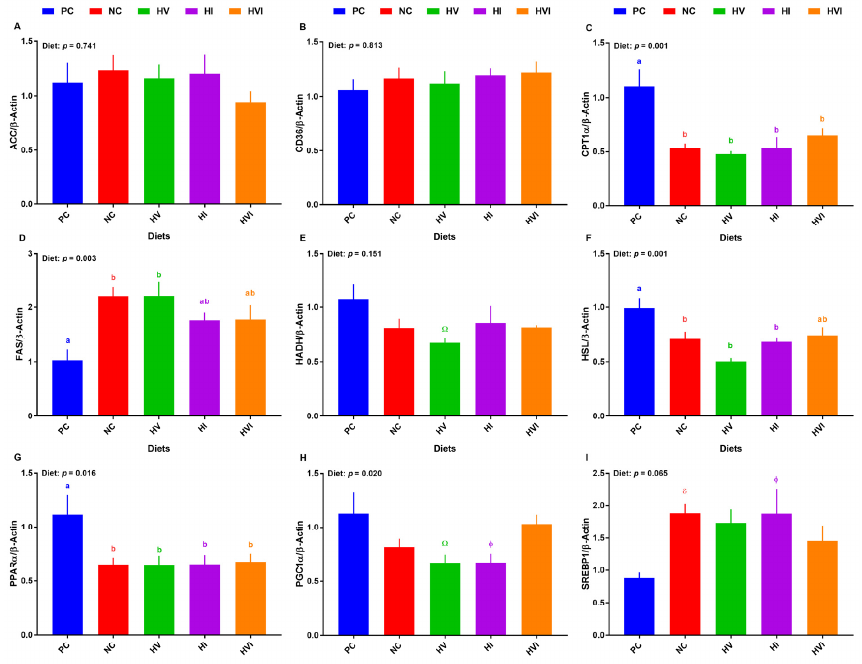
Figure 4. mRNA abundance of lipid metabolism markers in liver of nursery pigs fed with very low protein diets containing isoleucine (Ile), valine (Val), or mix of both above NRC levels. ( A ) acetyl-CoA carboxylase alpha ( ACC ), ( B ) cluster of differentiation 36 molecule ( CD36 ), ( C ) carnitine palmitoyltransferase I α ( CPT1 α ), ( D ) fatty acid synthase ( FAS ), ( E ) hydroxyacyl-CoA dehydrogenase ( HADH ), ( F ) hormone-sensitive lipase ( HSL ), ( G ) peroxisome proliferator activated receptor alpha ( PPAR α ), ( H ) PPAR γ coactivator 1 alpha ( PGC1 α ), and ( I ) sterol regulatory element-binding protein 1 ( SREBP-1 ). PC: positive control, standard protein diet; NC: negative control, very low protein diet containing the first four limiting amino acids (i.e., lysine, methionine, threonine, and tryptophan) at NRC levels; HV: NC containing Val above NRC level; HI: NC containing Ile above NRC level; and HVI: NC containing both Val and Ile above NRC level. The values are means ± standard error of the mean. n = 8. a,b,ab Among groups, the means with different superscript letter(s) are different ( p ≤ 0.05). δ p ≤ 0.1 PC vs. NC, Ώ p ≤ 0.1 HV vs. PC, ϕ p ≤ 0.1 HI vs. PC.